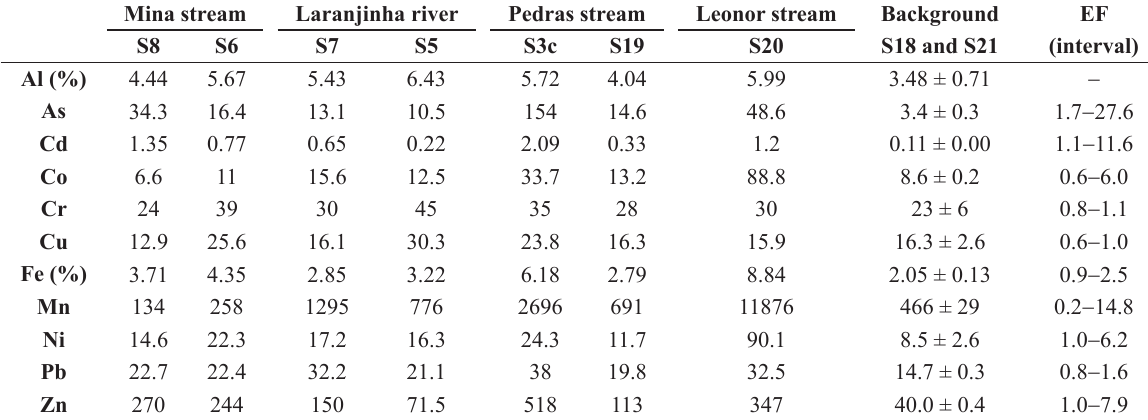
Total concentration of chemical constituents in stream sediments, background values (in mg kg −1 unless otherwise indicated) and enrichment factors